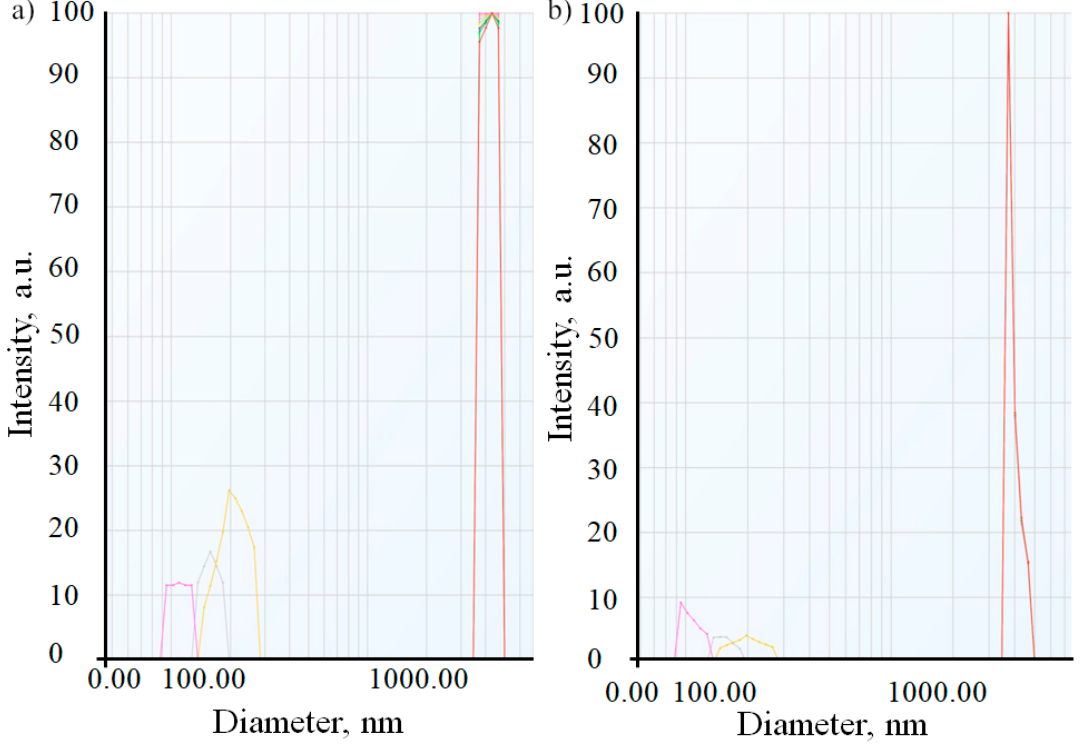
Figure 4. Particle size distribution for the ZnO NPs–Xym ( a ) sample by scattering intensity and ( b ) over the scattering volume (multimodal mode).